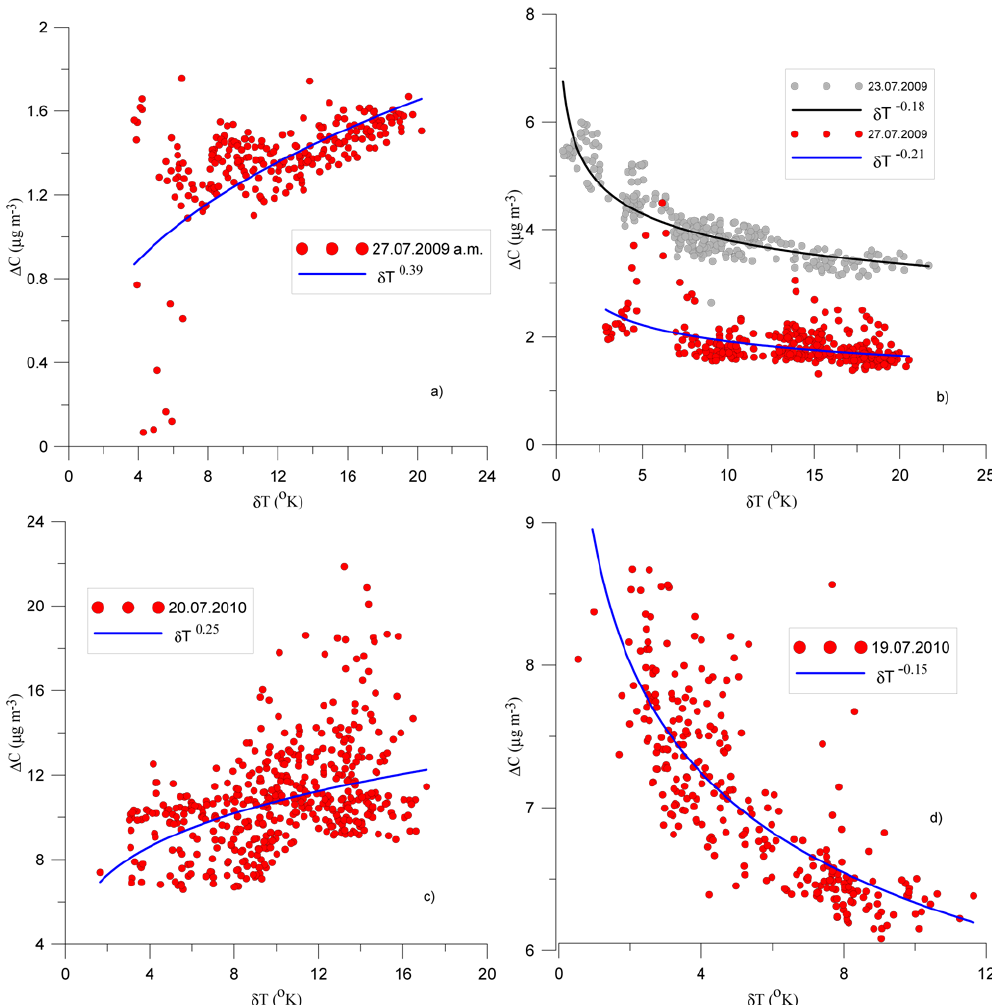
Fig. 7. Deviations of aerosol mass concentrations at a height 0.5m from 1.5-m (for 2009) (µgm − 3 ) for particles 0.15–0.5µm as a function of the temperature difference δT between the ground surface and 0.2m; (a) for 27 July a.m, 2009, the solid line denotes 1C ∼ δT 0 . 39 , (b) for 27 July p.m.., 2009, the solid line denotes 1C ∼ δT − 0 . 21 , for 23 July p.m. 2009, the solid line denotes 1C ∼ δT − 0 . 18 , (c) for 20 July 2010, the solid line denotes 1C ∼ δT 0 . 25 , (d) for 19 July 2010, the solid line denotes 1C ∼ δT − 0 . 15